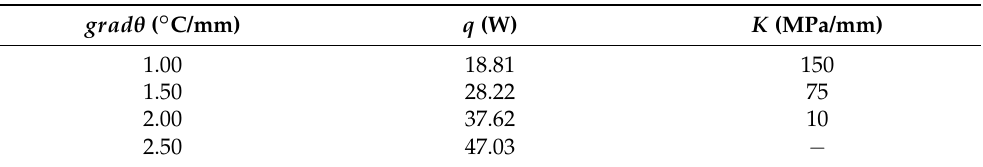
Table 10. Heat q [W] generated at the base of the microprocessor and its respective maximum Winkler elastic support